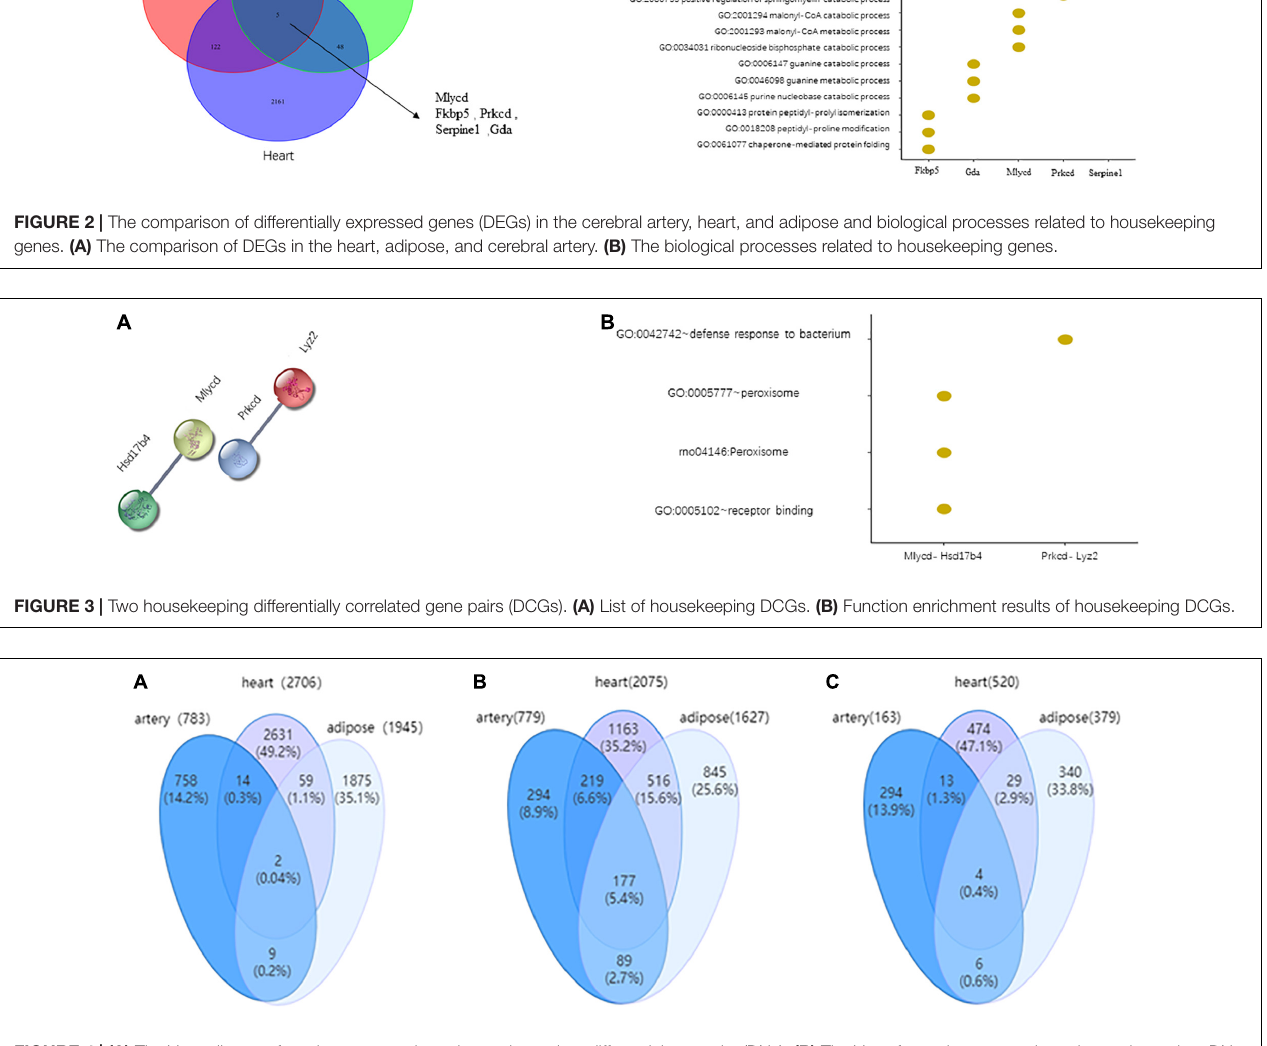
FIGURE 4 | (A) The Venn diagram for edges among three tissue-dependent differential networks (DNs). (B) The Venn for nodes among three tissue-dependent DNs. (C) The Venn for differentially expressed genes (DEGs) covered by three tissue-dependent